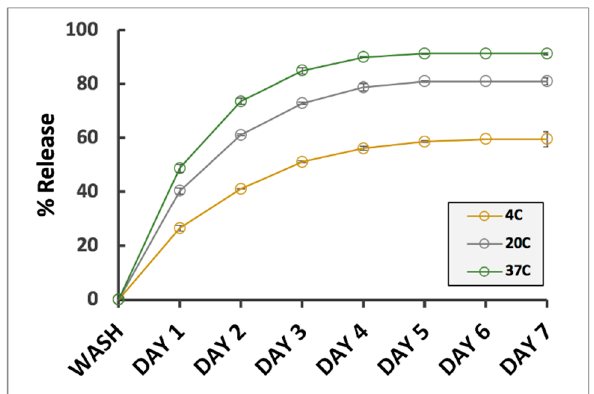
Figure 5. Temperature effect on drug release rates from TXGs. Error bars are hidden in the plot symbols when not visible.